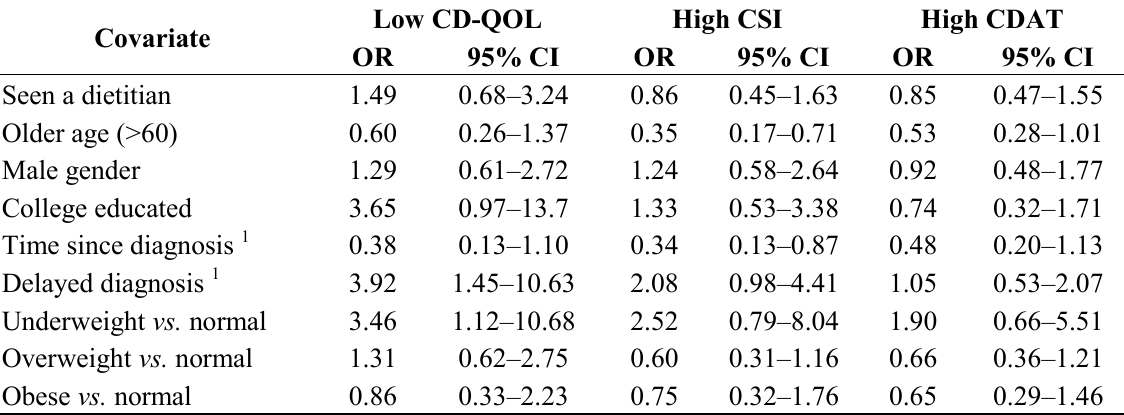
Table 4. Multivariate analysis of factors associated with low celiac disease quality of life (CD-QOL), high CD symptom index (CSI), and high CD adherence test (CDAT). Low Covariate